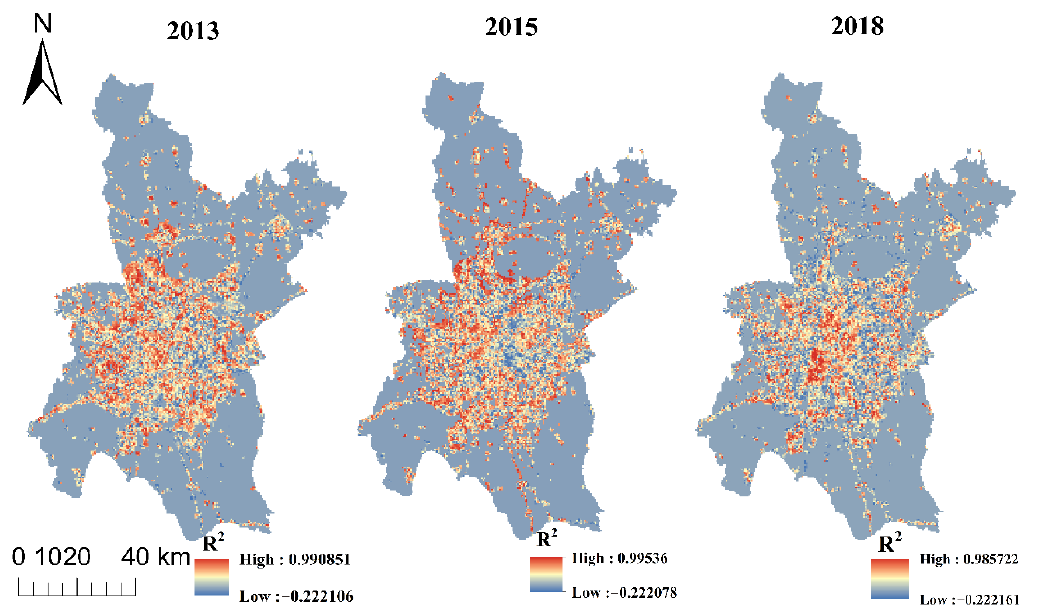
Figure 7. Seasonal variations in Wuhan at the pixel scale during 2013–2018.